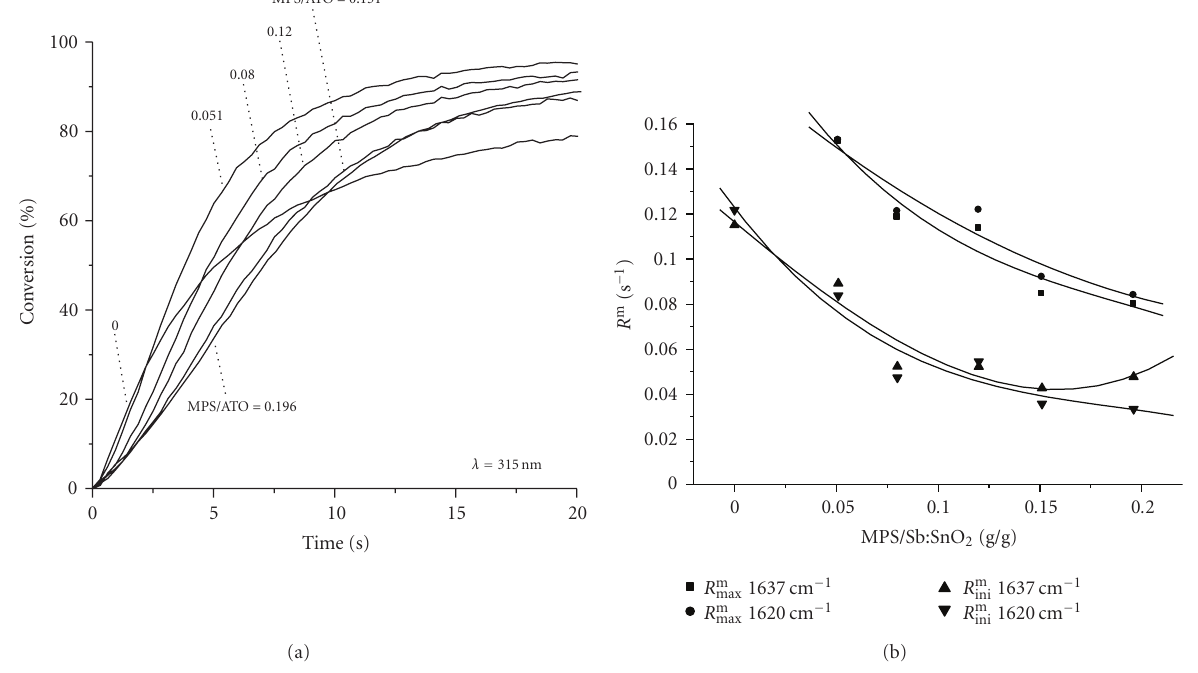
Figure 6: Dependency of the photocatalysed C = C bond conversion on the MPS amount present in the Sb:SnO 2 /PEGDA formulations (10vol.% Sb:SnO 2 , Sb = 7% Sb; MPS / Sb : SnO 2 = 0 . 08 g/g). (a) Relative conversions of C = C bonds measured at 1637 cm − 1 . (b) R m as a function of MPS/Sb:SnO 2 ratios measured at 1637 and 1620cm − 1 .